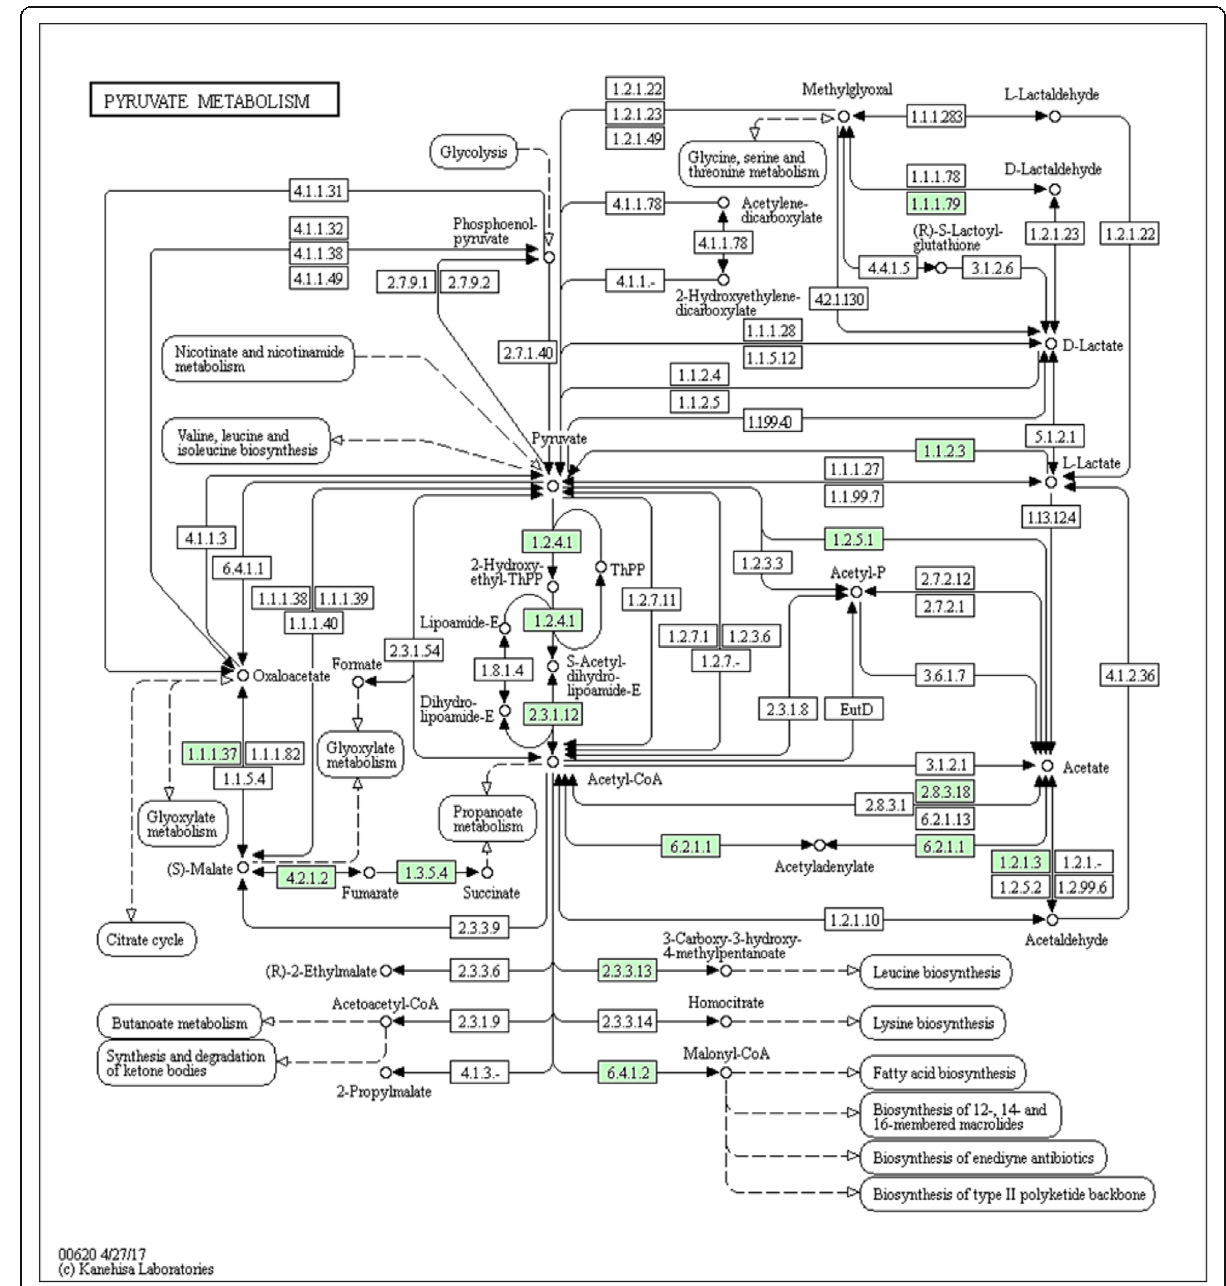
Fig. 5 Pathway for pyruvate metabolism performed using the KEGG pathway in KEGG Orthology. EC numbers in green are the enzymes identified in AB1